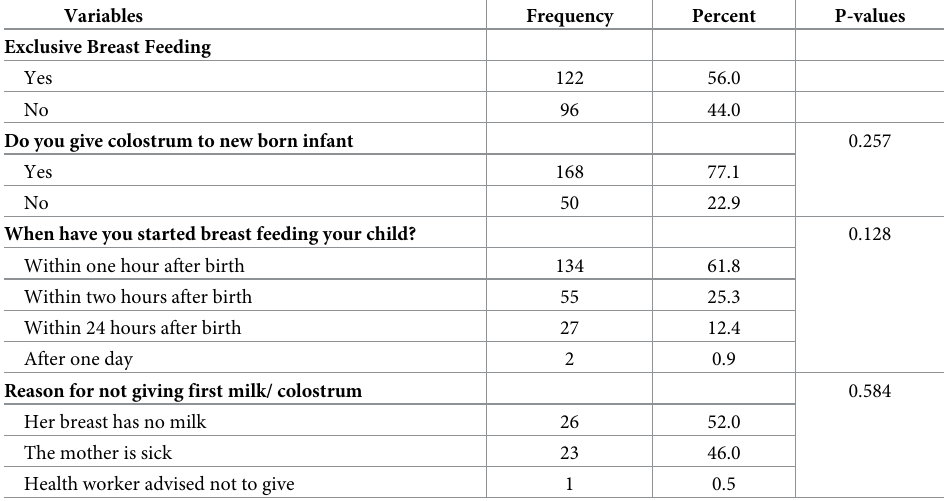
Table 3. Exclusively breast-feeding practice among HIV positive mothers in west, east and kellem Wollega Dis- tricts health institutions western Ethiopia, September 2017 to June 30, 2018. Variables